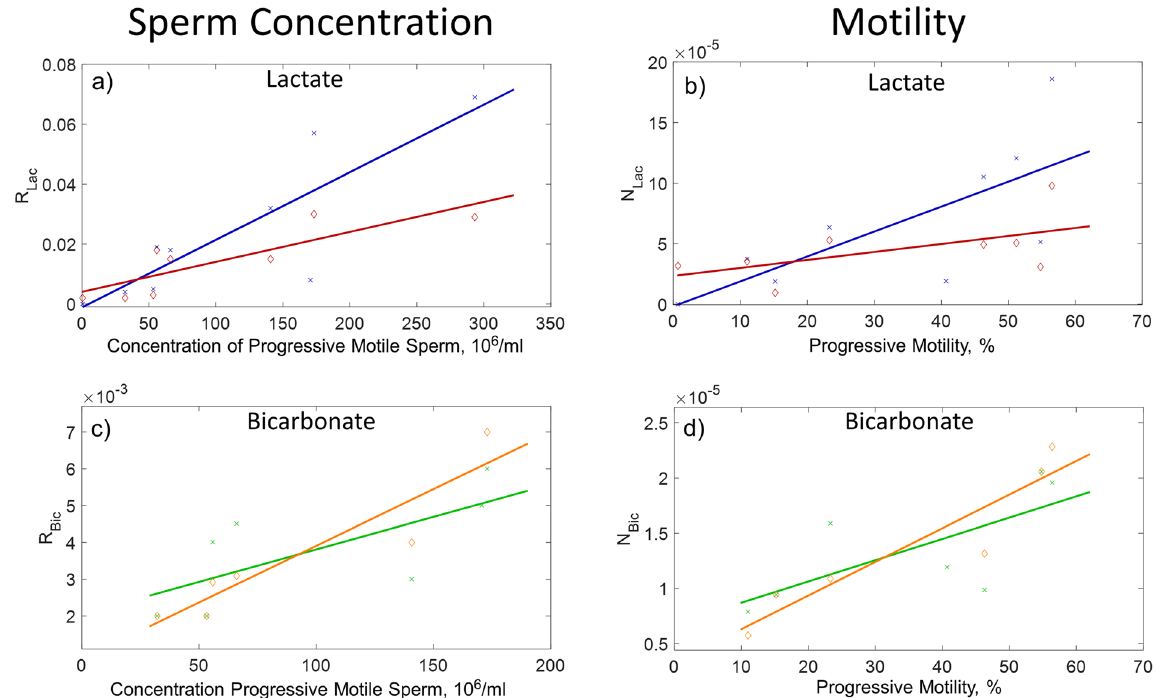
Figure 4. Progressive motile sperm concentration versus sperm metabolism of pyruvate to lactate, R Lac , (Panel a) and pyruvate to bicarbonate, R Bic , (Panel c). Sperm progressive motility versus total sperm concentration normalized metabolism of pyruvate to lactate, N Lac , (Panel b) and pyruvate to bicarbonate, N Bic , (Panel d). R Lac and R Bic were calculated as the ratio of the area under the curve for lactate:pyruvate or bicarbonate:pyruvate, respectively, from the hyperpolarized lactate, bicarbonate and pyruvate peak integrals obtained from each spectrum in the time course (180 spectra, 3 minutes). Concentration normalized, N Lac and N Bic , values were calculated by dividing each sample value for R Lac and R Bic by its respective sperm concentration (10 6 /ml). Each panel shows pyruvate metabolism for sequential hyperpolarized experiments separated by ~1 hour whilst the sperm were retained in the magnet at 37 °C. The 1 st pyruvate addition are represented by cross markers and 2 nd pyruvate addition diamond markers. Sperm concentration and progressive motility were measured prior to addition to the NMR